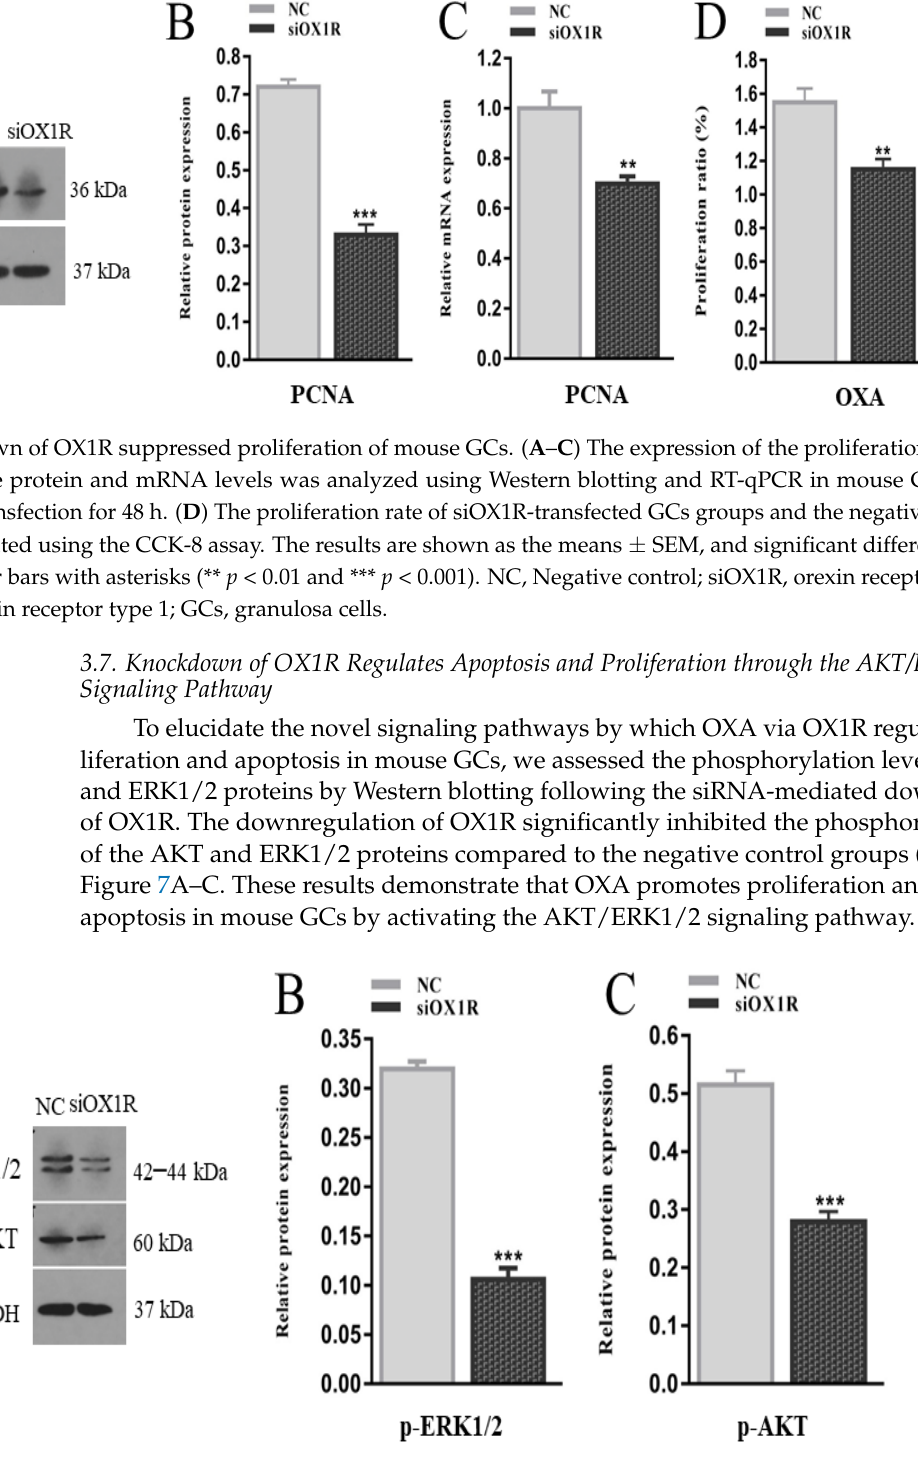
10 of 16 Figure 5. OX1R silencing induced S-phase arrest of the cell cycle in mouse GCs. ( A ) Measurement of the cell cycle progres- sion using flow cytometry in mouse GCs after transfection with siOX1R for 48 h and ( B ) the cells distribution in different phases of the cell cycle. The significant difference (** p < 0.01) between different groups is shown with letters ‘a’ and ‘b’ within columns. ( C – E ) The expression of P21 at the mRNA and protein levels. The data are shown as the means ± SEM (** p < 0.01, *** p < 0.001). OX1R, orexin receptor type 1; NC, negative control; GC, granulosa cells; siOX1R, orexin receptor 1 siRNA; FACS, fluorescence-activated cell sorting. 3.6. Knockdown of OX1R Inhibited Proliferation of Mouse GCs In Vitro To find out the role of OXA in cell proliferation, following the siRNA-mediated downregulation of OX1R, the proliferation rate in mouse GCs was measured using Cell Counting Kit-8. The results revealed that OX1R silencing led to the suppression of prolif-